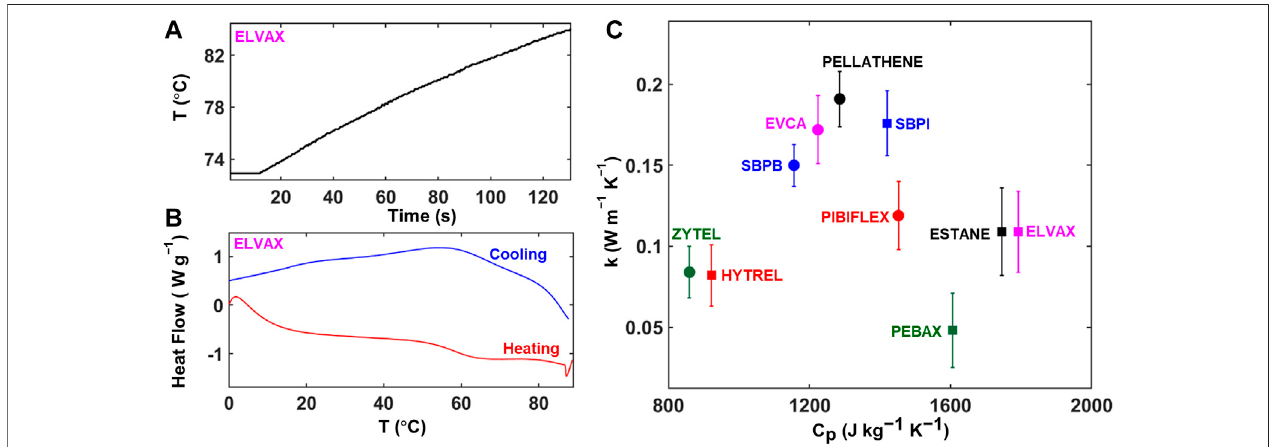
FIGURE3| Thermalpropertymeasurement. (A) Transienttemperaturepro fi lefromthethermalconductivitymeasurementforarepresentativematerial(ELVAX). (B) DSCendo-andexothermsusedforspeci fi cheatcapacitycalculationshownforELVAX. (C) Plotshowingthemeltthermalconductivityandspeci fi cheatcapacityat35 ° C for the TPEs tested.